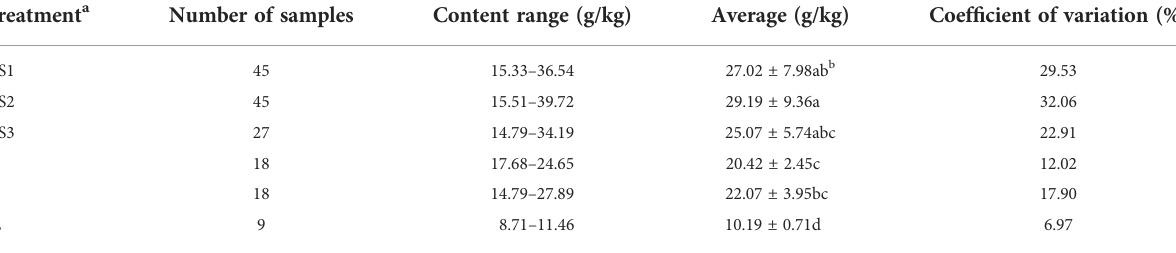
TABLE 2 Soil organic matter content under different planting patterns of maize and soybean in 2018 – 2020. Treatment